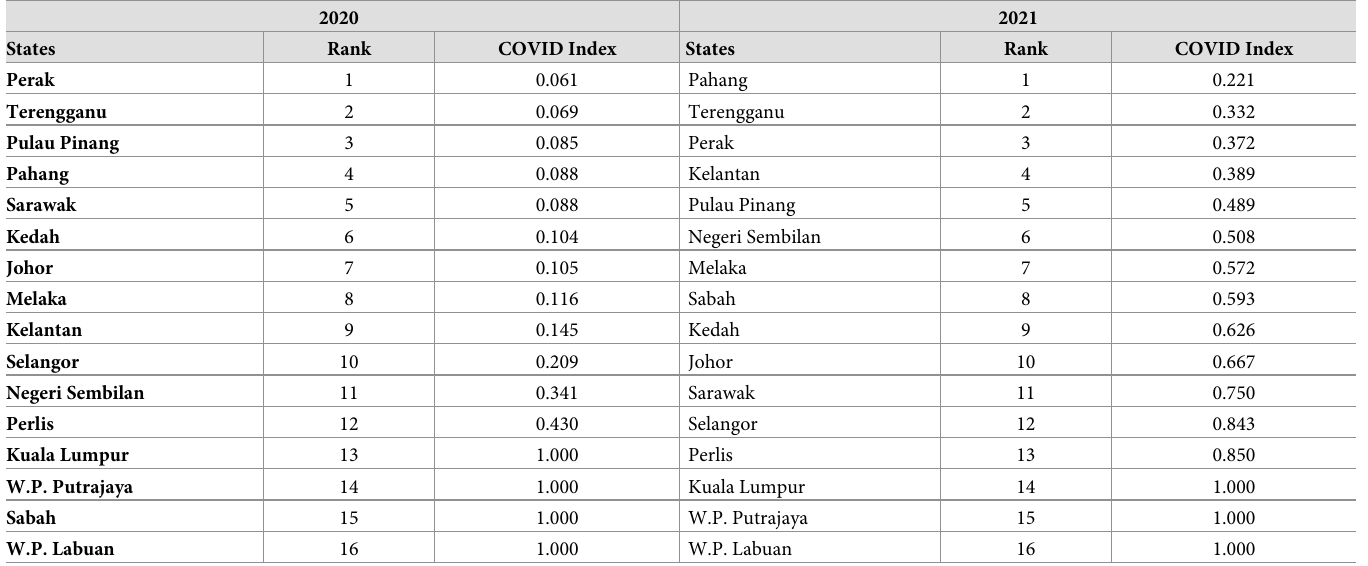
Table 4. COVID index in 2020 and 2021.